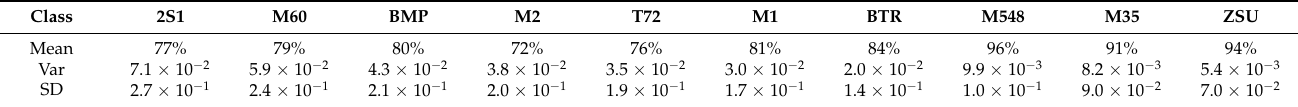
Figure 8. ResNet18 SAR-only accuracy distributions during training.